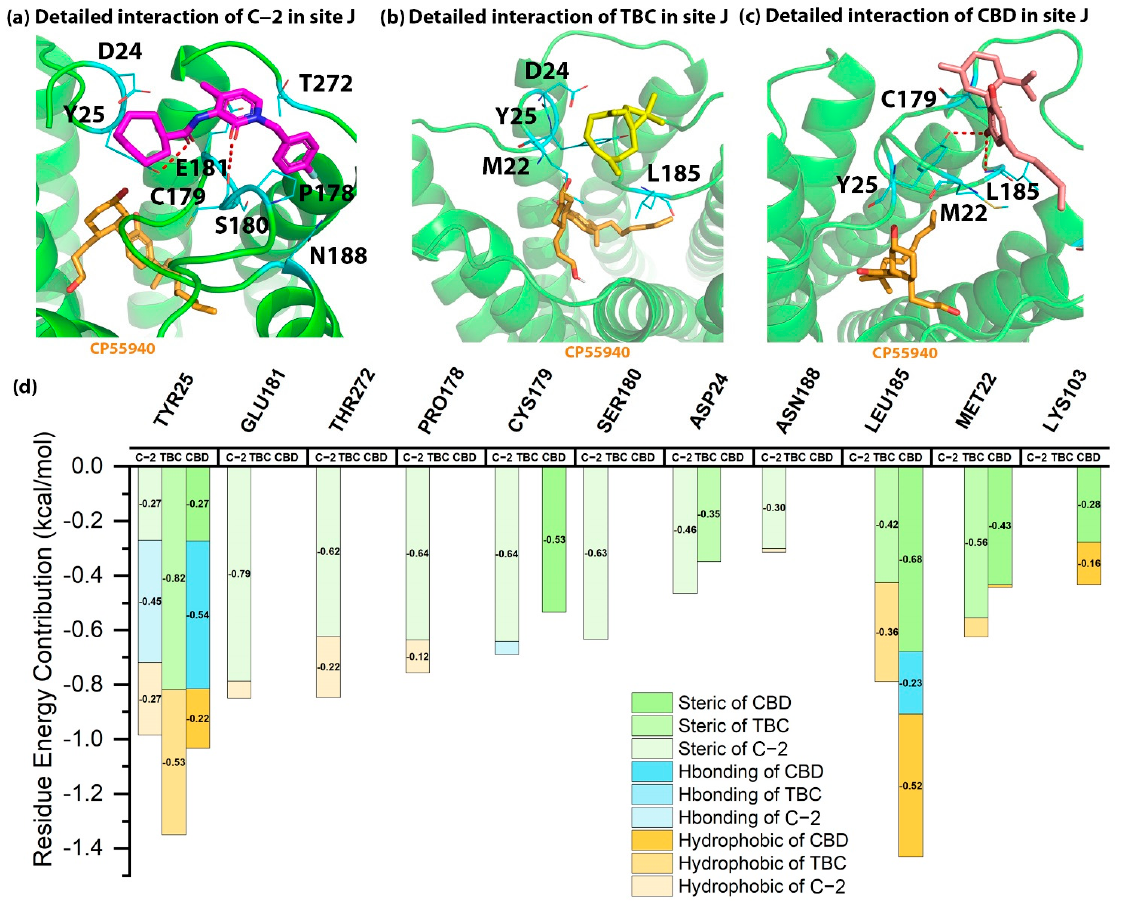
Figure 6. The detailed interactions and residue energy contribution of C-2, TBC and CBD in site J. ( a ) The detailed binding pose of C-2 in site J. ( b ) The detailed binding pose of TBC in site J. ( c ) The detailed binding pose of CBD in site J. ( d ) The comparisons of residue energy contribution of the binding residues for these AMs in site J.